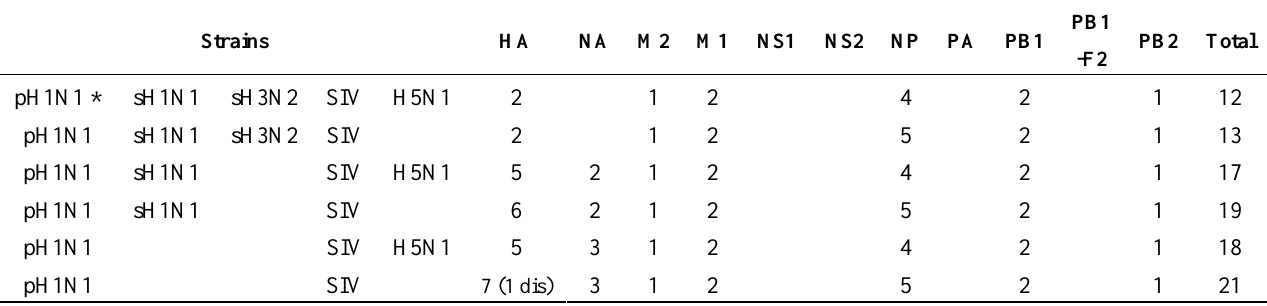
Table 1. B-cell epitopes of A (H1N1)pdm09 shared with other influenza strains and subtypes. Strains HA NA M2 M1 NS1